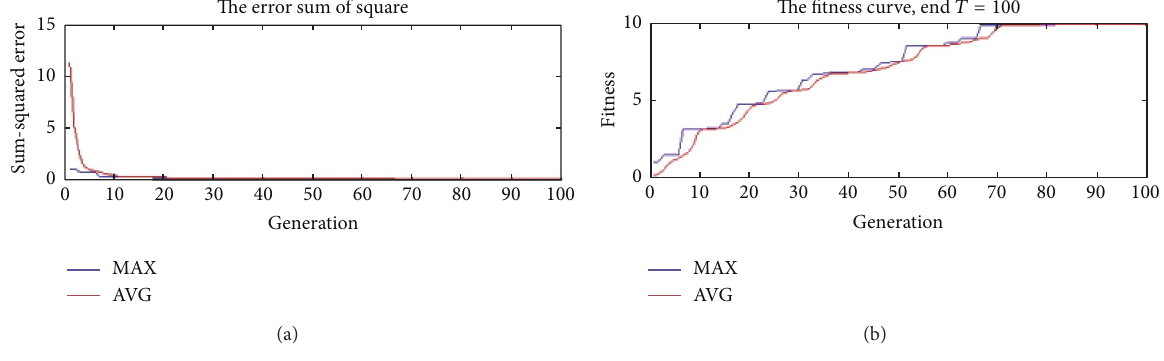
Figure 3: The error sum of square and the fitness curve.